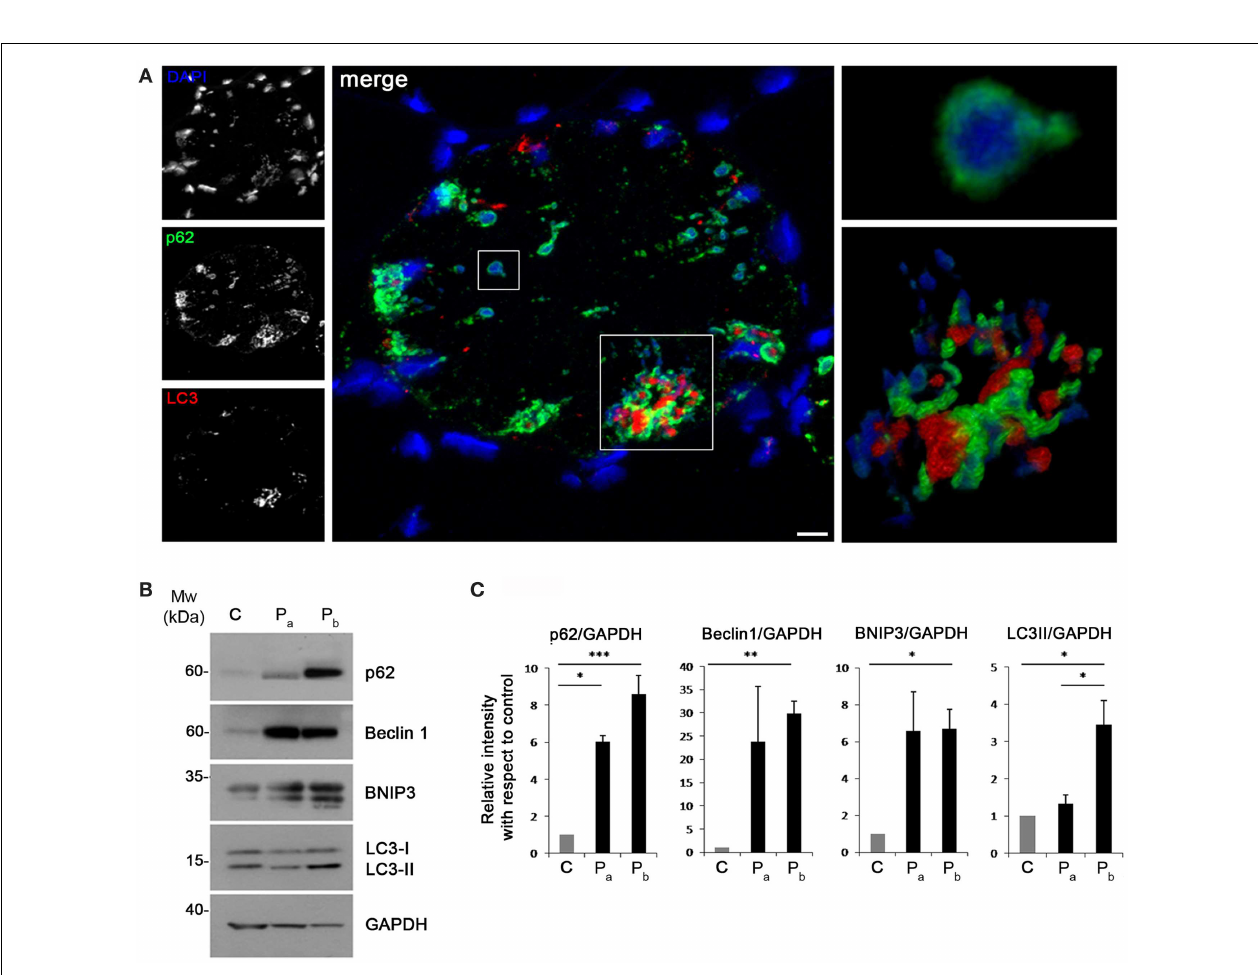
FIGURE 4 | (A) Confocal immunofluorescence imaging of the patient muscle biopsy labeled with LC3 antibody (red), p62 antibody (green), and DAPI (blue). The maximum intensity projections of the single channels (white) are shown on the left, the merged image of confocal projections are shown in the middle, and the 3D surface shaded reconstruction of an enlargement of the areas defined by the white boxes are shown on the right. Scale bar, 10 µ m.